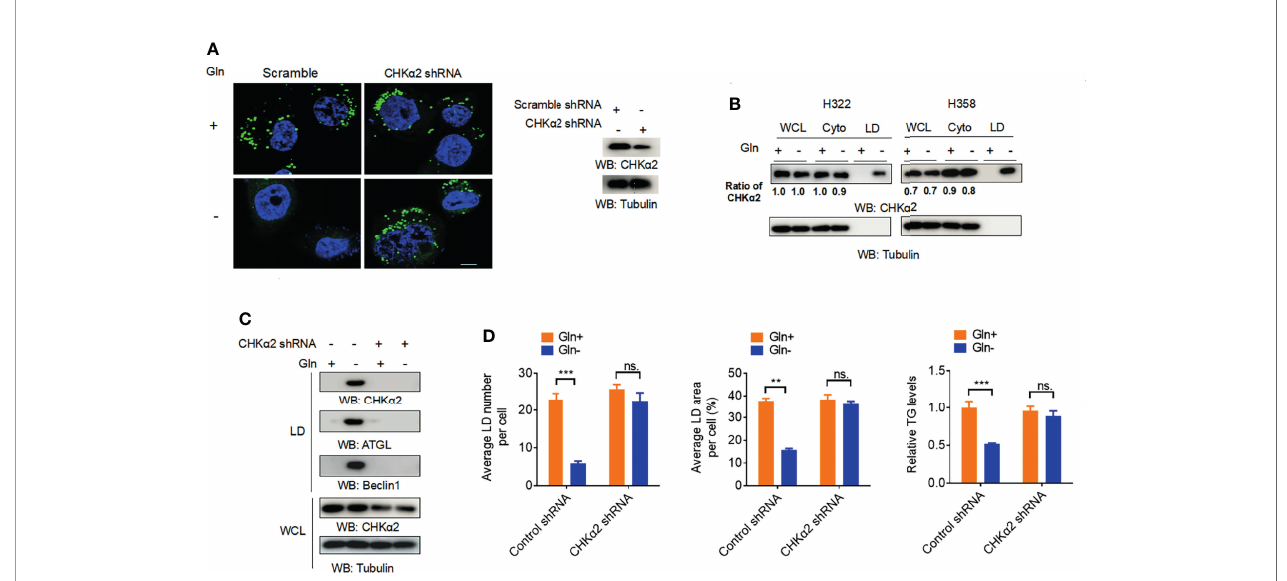
FIGURE 1 | Glutamine deprivation induces the binding of CHK a 2 to lipid droplets and subsequently CHK a 2-dependent lipid droplet lipolysis in NSCLC cells. (A) H322 cells were stimulated with glutamine deprivation with or without expression of CHK a 2 shRNA for 6 h. Representative images of lipid droplets are shown (left panel). Immunoblotting with the indicated antibodies was performed (right panel). Scale bar: 10 m m. (B) CHK a 2 expression in whole cell lysate (WCL), cell cytoplasm (Cyto), and lipid droplets (LD) was examined by stimulating H322 and H258 cells with glutamine deprivation for 6 h. (C) H322 cells with or without CHK a 2 shRNA expression were stimulated with glutamine deprivation for 6 h. Expression levels of the indicated proteins were detected in WCL or puri fi ed lipid droplet samples. (D) H322 cells with or without expression of CHK a 2 shRNA were stimulated with glutamine deprivation for 6 h. The number and area of lipid droplets were quanti fi ed after staining of cells using BODIPY, and relative TG levels were counted. Data represent the mean ± SD of 3 independent experiments. ns, not signi fi cant; **P < 0.01; ***P <